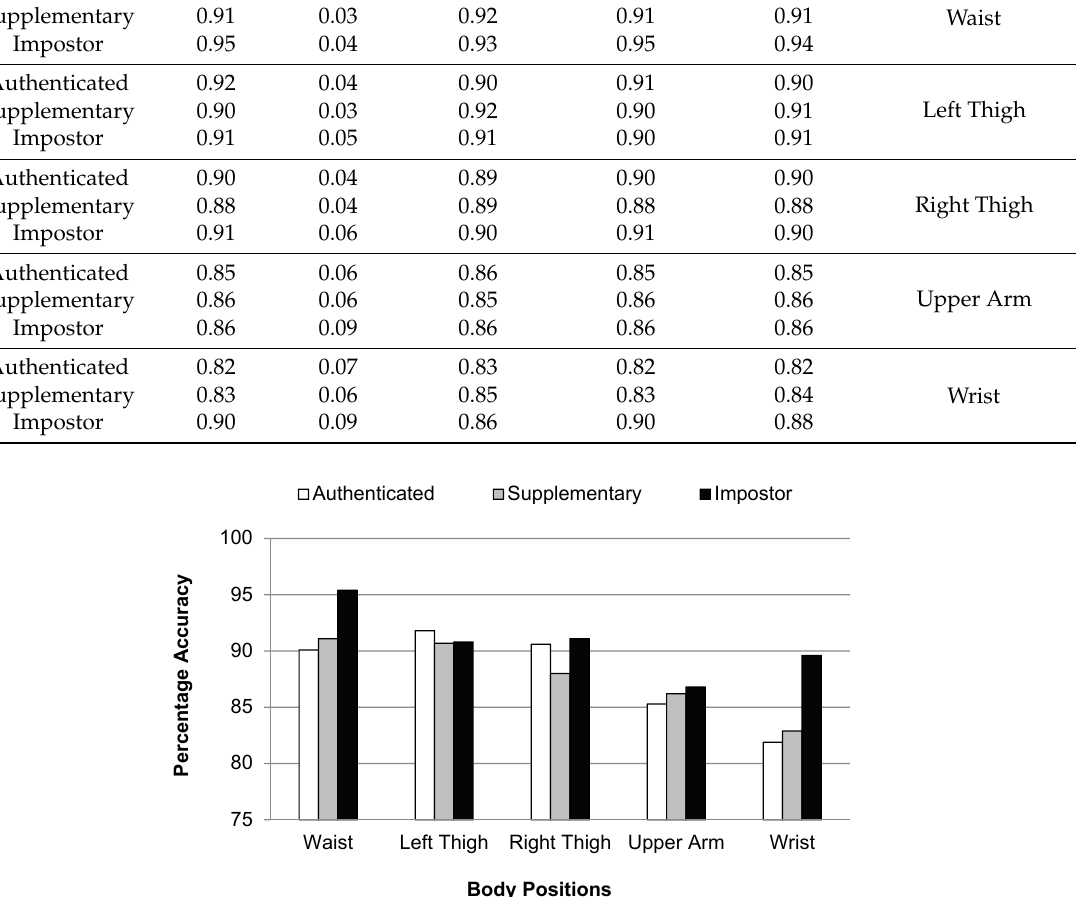
Table 8. Results of user classification based on activity recognition at five body positions.